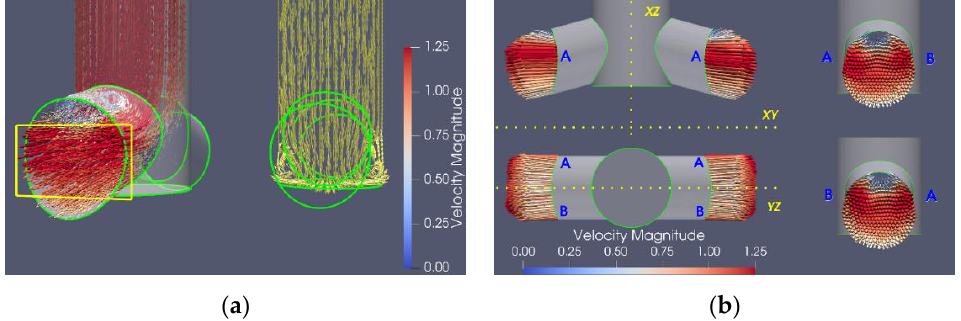
Figure 5. Hydrodynamic behavior inside a FB nozzle. ( a ) Fluid velocity vectors inside the nozzle. ( b ) Fluid velocity vectors as seen from the outlet ports. The letters A and B label the exit ports’ sides. Figure 5a reconstructs the behavior using fluid velocity vectors along the